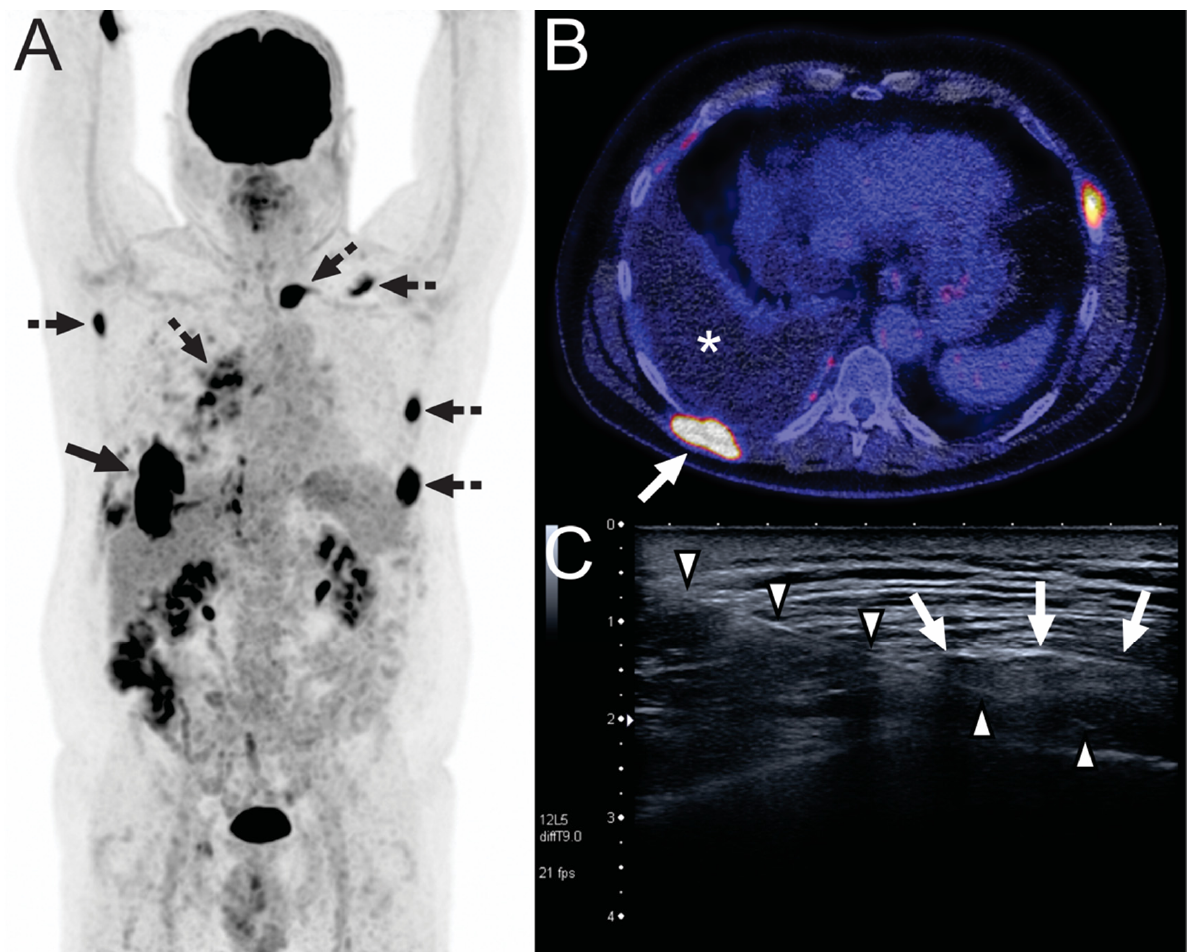
Figure 1. A 67-year-old man with stage IIIA right upper lobe lung adenocarcinoma was treated with chemotherapy and radiation therapy. Four months after completion of therapy, a CT scan (not shown) suggested tumor progression with a right-sided pleural fluid collection, for which a (talc) pleurodesis was performed. Subsequently, he was referred to our tertiary care center for immunotherapy with crizotinib. Another four months later, FDG-PET was performed for response evaluation. FDG-PET ( A ) showed multiple FDG-avid pleural and extrapleural lesions (dashed arrows), the largest at the right dorsal side of the chest wall (continuous arrow), suspicious for metastatic disease. The largest extrapleural lesion on the right dorsal side of the chest wall is also seen on fused FDG-PET/CT (( B ), arrow), along with a pleural effusion (asterisk). Pleural fluid aspiration showed a lymphocytic exudate without any malignant cells. Subsequently, ultrasound-guided biopsy was ordered by the pulmonary oncologist for lung cancer mutation analysis. The ultrasound image ( C ) shows the biopsy needle (arrowheads) piercing the extrapleural lesion on the right dorsal side of the chest wall (arrows). Pathologic examination revealed a multinucleated giant cell reaction due to talc particles and no lung cancer.